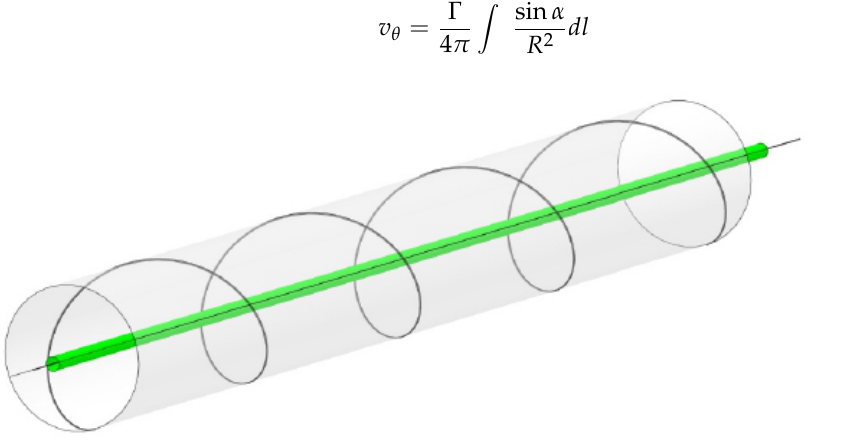
Figure 2. Diagram of the Biot–Savart’s